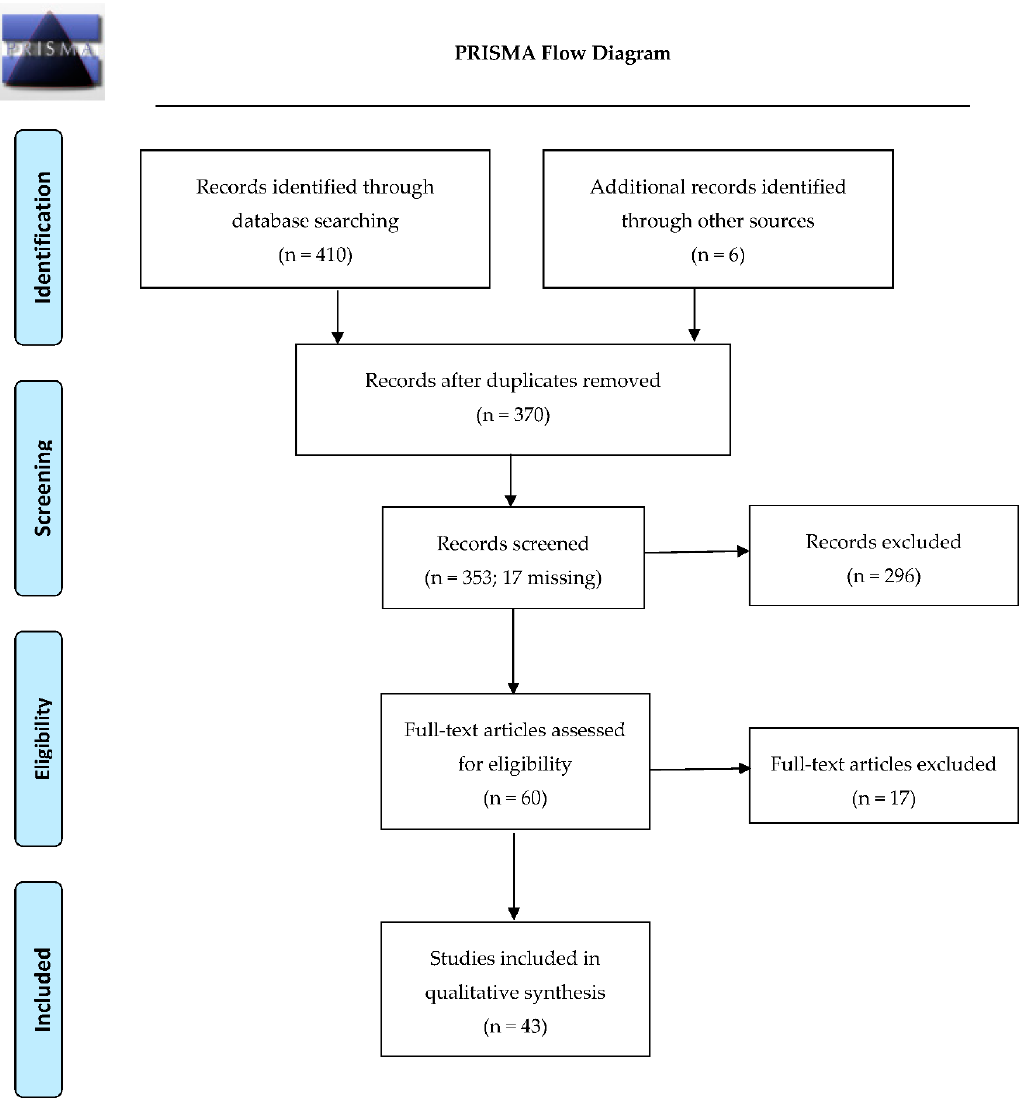
Figure 1. PRISMA flow diagram depicting the flow of information through the different phases of this scoping review. From: [35].